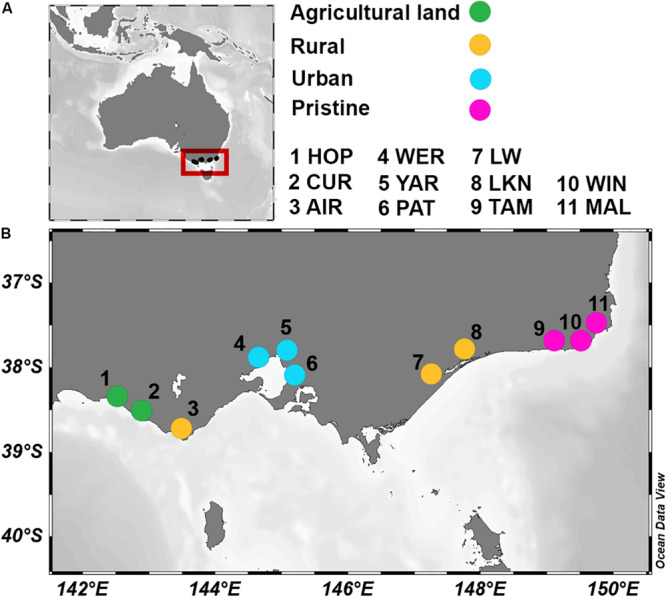
Location of the 11 estuaries in Australia (A) and, in greater detail, in the southwestern coast (B), as indicated by the red box in A. Colors indicate land usage. Hopkins River (HOP; Fert% 88.7 and Pop 5.5); Curdies River (CUR; Fert% 86.6 and Pop 5.5); Aire River (AIR; Fert% 14 and Pop 1); Werribee River (WER; Fert% 56.4 and Pop 58.3); Yarra River (YAR; Fert% 43.6 and Pop 347); Patterson River (PAT; Fert% 57.1 and Pop 1003); Lake Wellington (LW; Fert% 33 and Pop 11.6); Lake King (LKN; Fert% 14.7 and Pop 2.5); Tamboon Inlet (TAM; Fert% 1.9 and Pop 0.4); Wingan River (WIN; Fert% 0.5 and Pop 0.09); Mallacoota River (MAL; Fert% 2.9 and Pop 0.3).